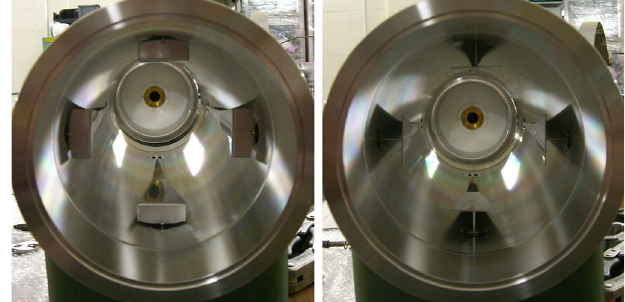
FIG. 18. Photographs of the concave pentagon electrodes with (left) and without the apron